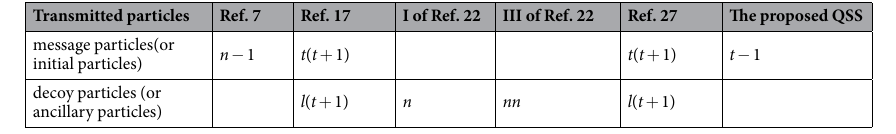
Table 3. Comparison of communication